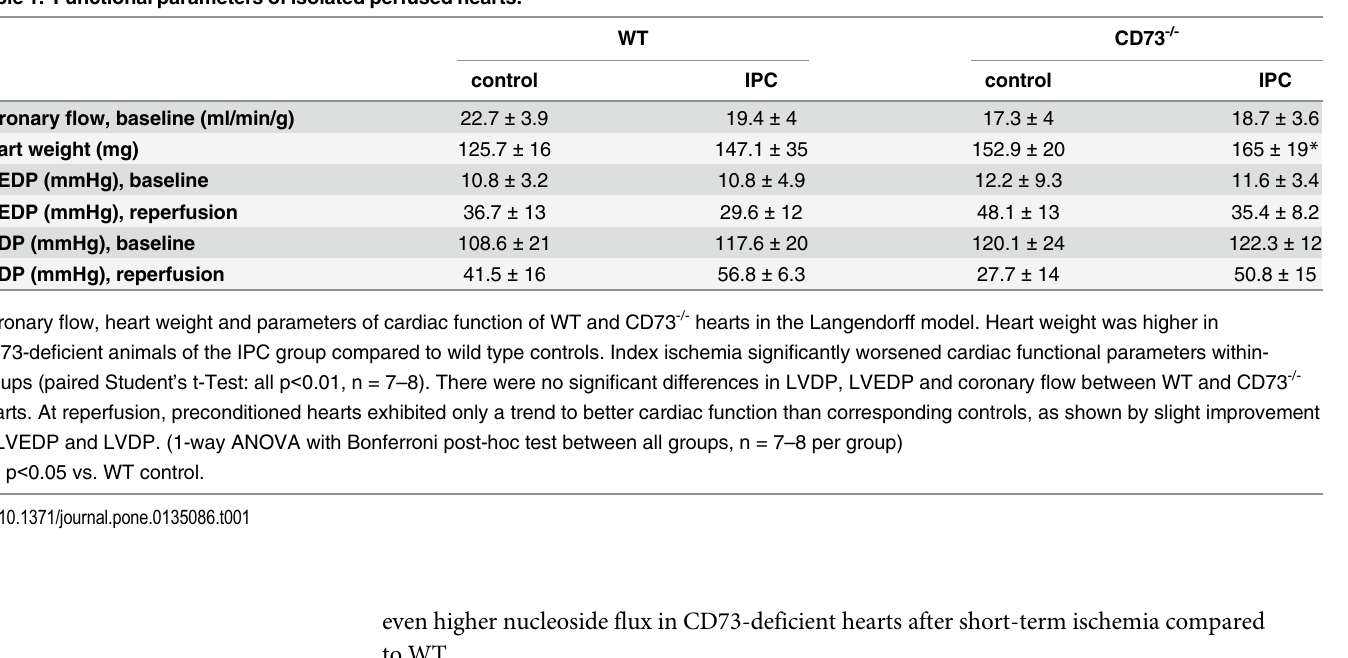
even higher nucleoside flux in CD73-deficient hearts after short-term ischemia compared to WT. Pharmacological preconditioning by intracoronary adenosine infusion. In order to understand whether the measured coronary venous adenosine concentration could trigger IPC